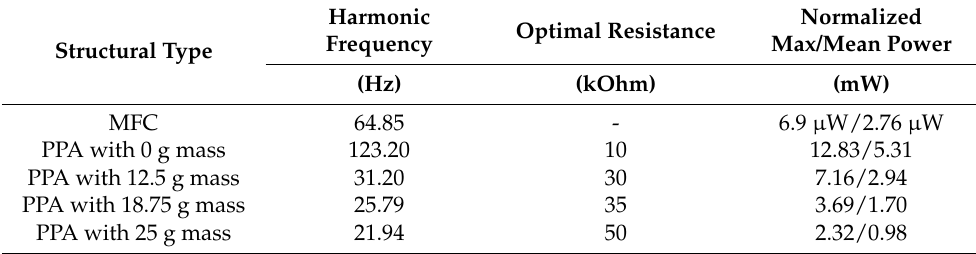
Table 1. Optimal settings of energy harvesters of MFC and PPA.